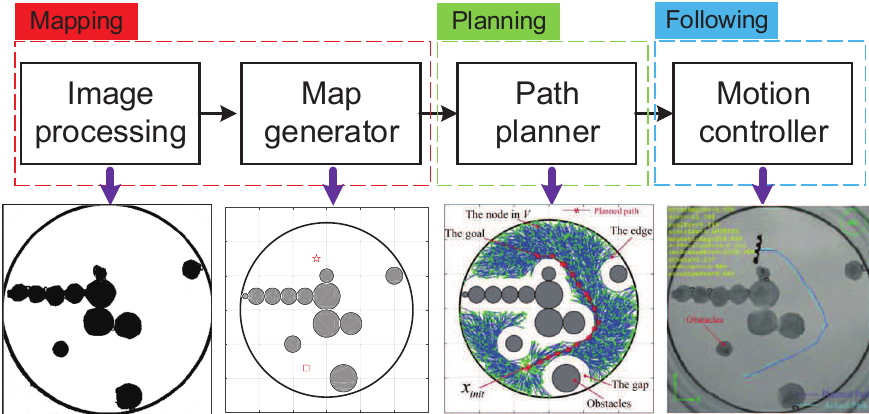
Figure 1. Schematic of automatic manipulation system for helical microswimmers: mapping, planning, and following. First, the map is determined via image morphological transformations. After the free space and the obstacle space are labeled, a global path in the obstacle-free space is generated by a path planner. Last, the path following controller makes the barycenter of helical microswimmers converge on the planned